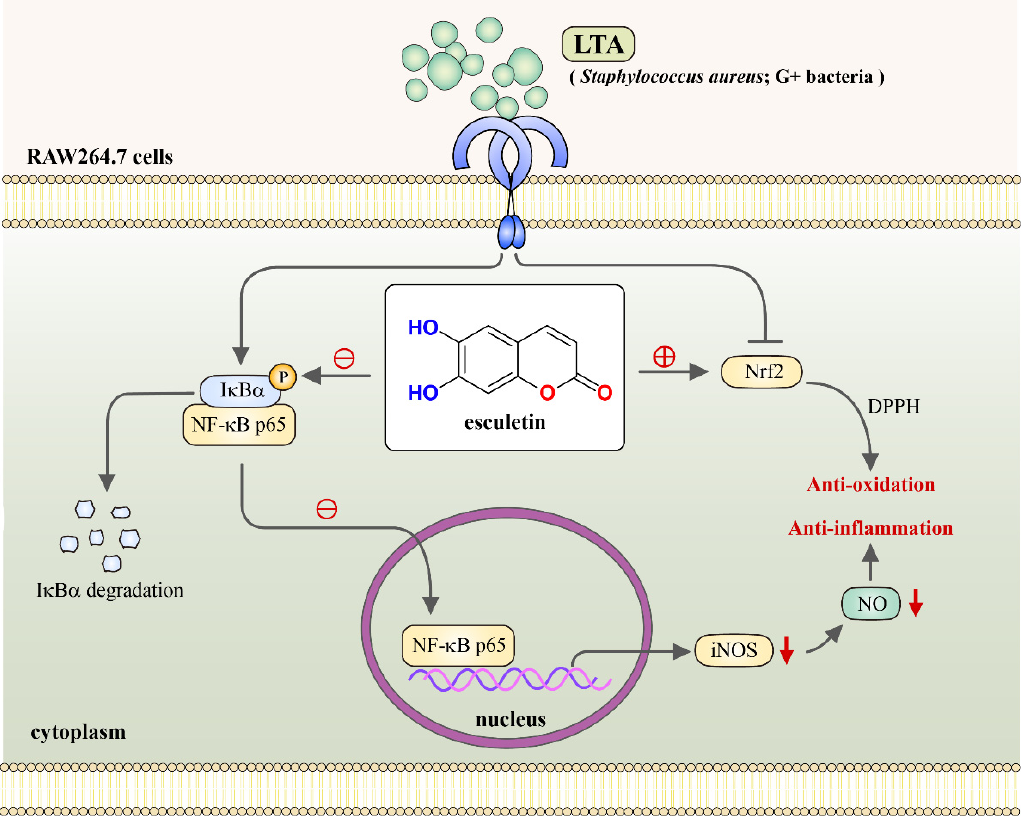
Figure 7. Schematic of the anti-inflammatory and anti-oxidative activities of esculetin in vitro. Es- culetin exerts anti-inflammatory activity by inhibiting the production of NO via suppression of NF- κ B, and enhancing Nrf2 expression. LTA, lipoteichoic acid; NO, nitric oxide; iNOS, inducible nitric oxide synthase; NF- κ B, nuclear factor kappa B; Nrf2, nuclear factor erythroid 2-related fac-